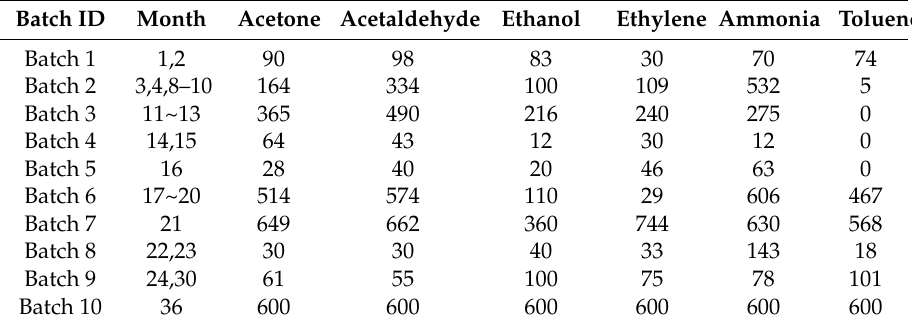
Table 1. Distribution of benchmark sensor drift dataset from